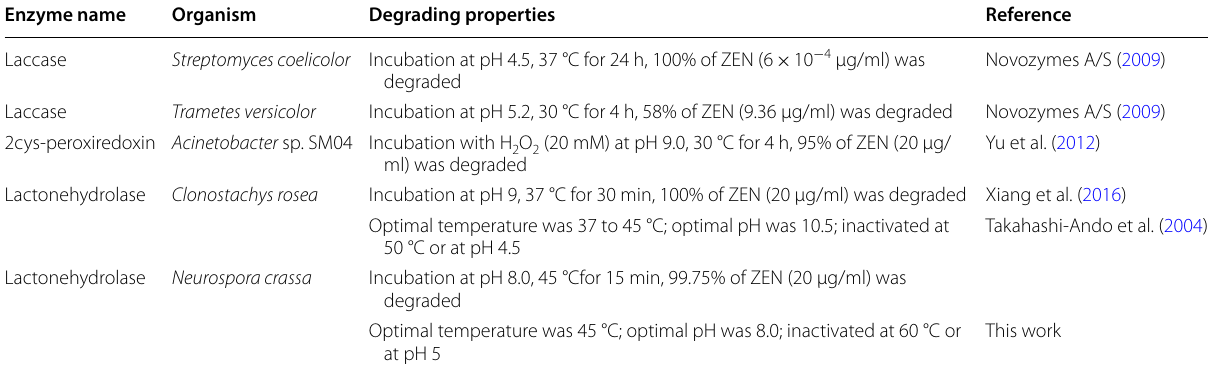
Table 3 Comparison of this work with literature reports on zearalenone degrading